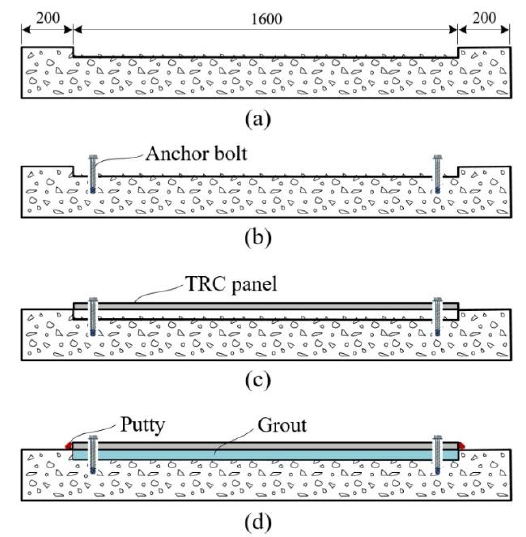
Figure 6. Strengthening process: ( a ) concrete surface chipping; ( b ) anchor bolts installation; ( c ) TRC panel assembling; ( d ) putty placement and grouting. Table 4. Mix composition of ready-mixed concrete (unit: kg/m 3 ).